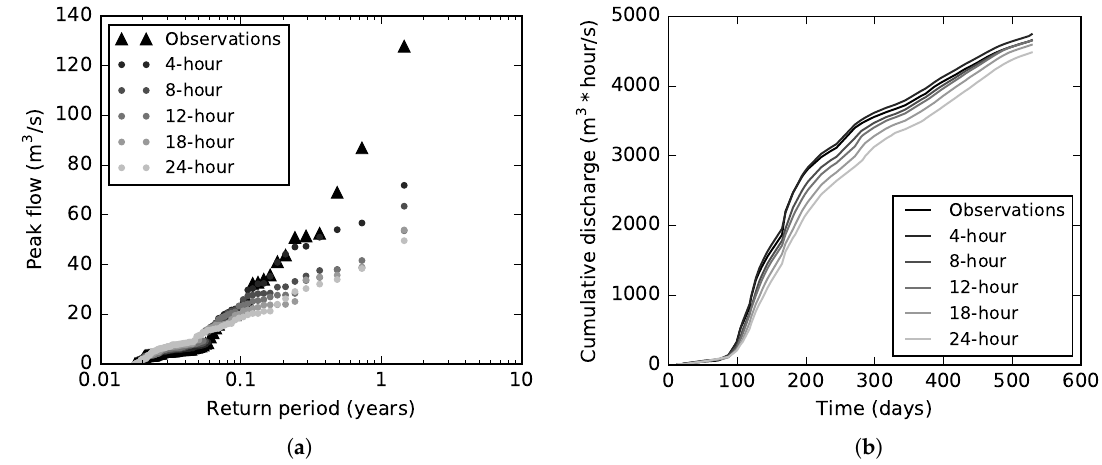
Figure 9. ( a ) Empirical extreme value distribution of peak flows, and ( b ) Comparison of cumulative flow volumes for forecasting models of 4, 8, 12, 18 and 24 h.